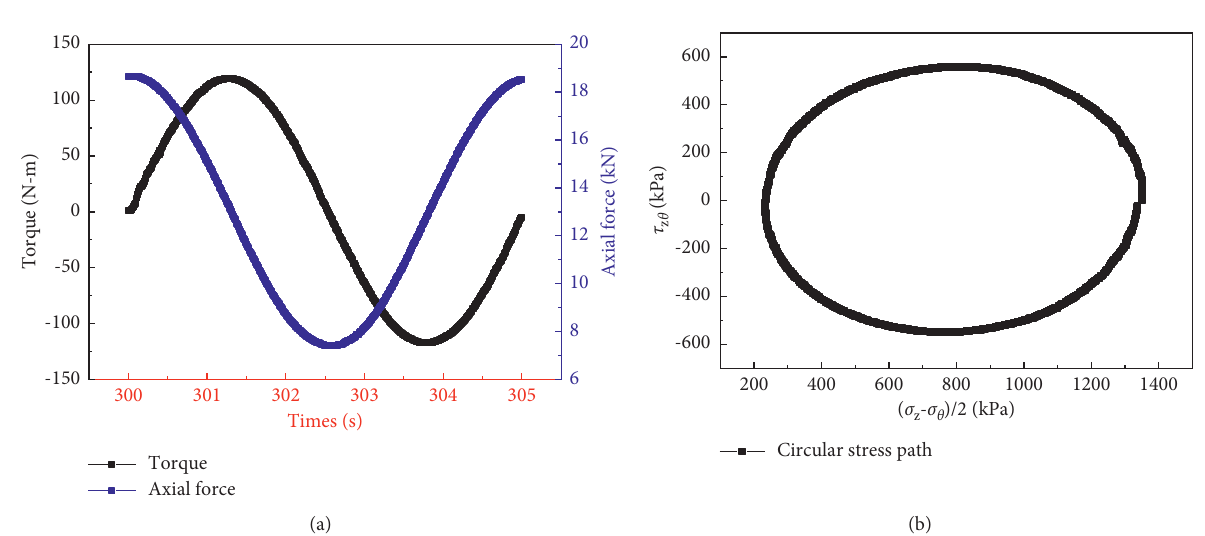
Figure 4: Representative loading waveforms and typical record of stress path. (a) Representative loading waveforms. (b) Typical record of stress path.